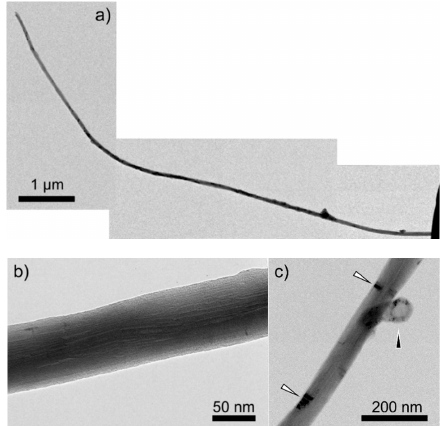
Figure 9. Bright field TEM images of NM-401 MWCNTs from the samples studied; ( a ) example of curved morphology, point defects and slight variations on the thickness; ( b ) example of the misalignment of the walls and ( c ) magnification images showing in detail ( b ), areas with a disturbed structure (darker regions) and a branch on the body of the tube ( c ). Images ( a ) and ( c ) acquired at an acceleration voltage of 200 kV, and ( b ) at 80